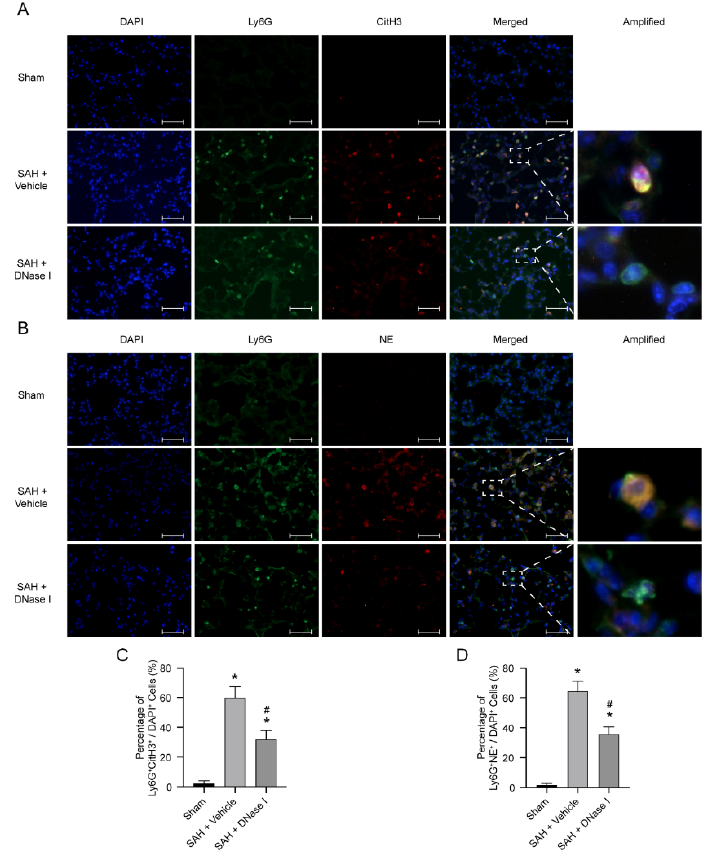
Figure 2. DNase-1 inhibits the formation of NETs in the NPE after SAH. ( A ) Representative photo- graph of the colocalization of CitH3 (red) with Ly6G (green) among the groups. The nuclei were stained with DAPI (blue). Scale bar = 50 μ m. ( B ) Representative photograph of the colocalization of NE (red) with Ly6G (green) among the groups. The nuclei were stained with DAPI (blue). Scale bar = 50 μ m. ( C ) Quantitative analysis of CitH3-positive neutrophils; n = 5/group. ( D ) Quantitative analysis of NE-positive neutrophils; n = 5/group. * p < 0.05 versus the sham and # p < 0.05 versus the SAH + vehicle